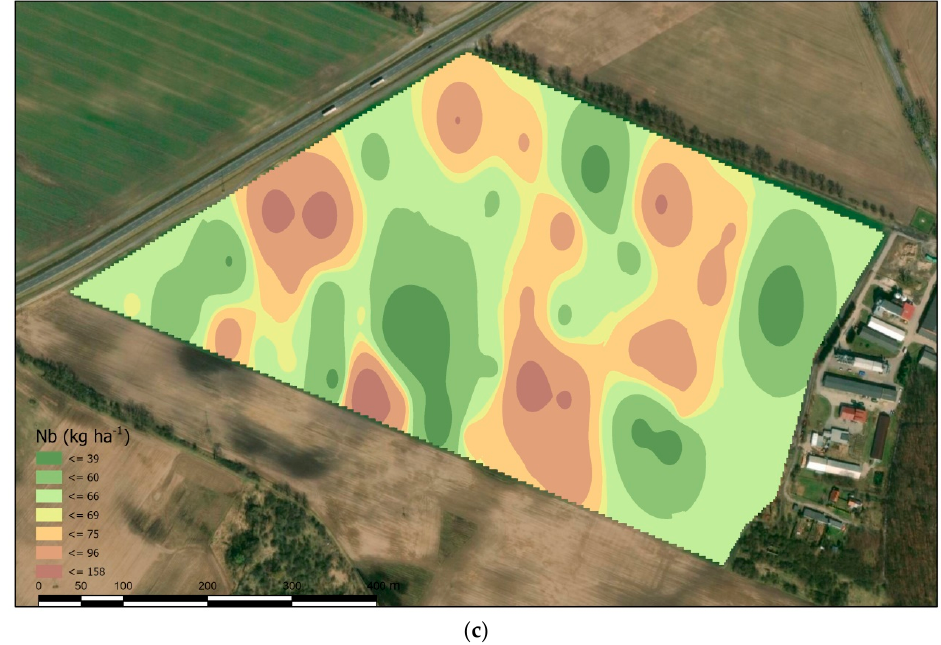
Figure 4. ( a ) Spatial distribution map of winter triticale (cereals units) yield. ( b ) Spatial distribution map of nitrogen input to winter triticale at the onset of the 2017/2018 growing season. ( c ) Spatial distribution map of nitrogen balance during the winter triticale growing season.